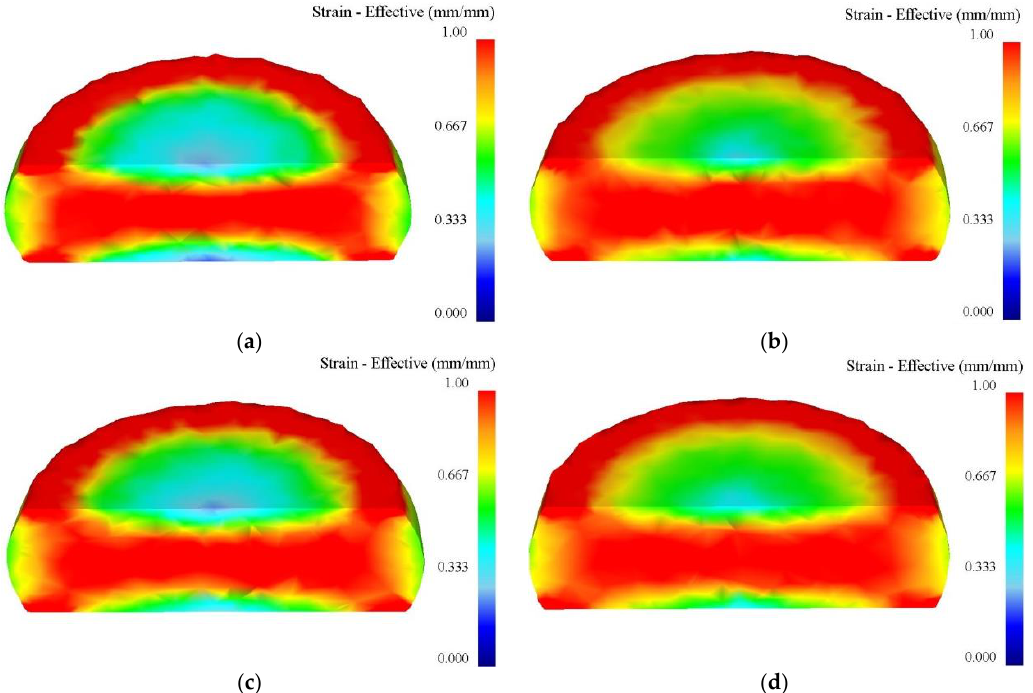
Figure 12. The effective strain distributions under the deformation conditions of ( a ) 1153 K and 0.1 s − 1 ; ( b ) 1303 K and 0.1 s − 1 ; ( c ) 1153 K and 1 s − 1 and ( d ) 1253 K and 1 s − 1